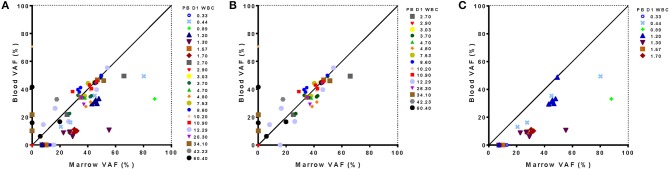
Relationship between sequence variants detected from blood and marrow samples in AML patients. Results of targeted DNA sequencing at day 1 of treatment show good concordance with outliers associated to extremes of white blood cell (WBC) count in blood. Variant allele frequency detected from in blood and marrow is shown for all 22 patients evaluated (A), just those patients with WBC >2,500/μl (B) or just those patients with WBC <2,500/μl in blood (C). Leukopenic patients had lower VAF in blood for variants identified from marrow. One patient had no detectable mutations in either blood or marrow. PB D1 WBC, White blood cell count in blood on Day 1; VAF, variant allele frequency.